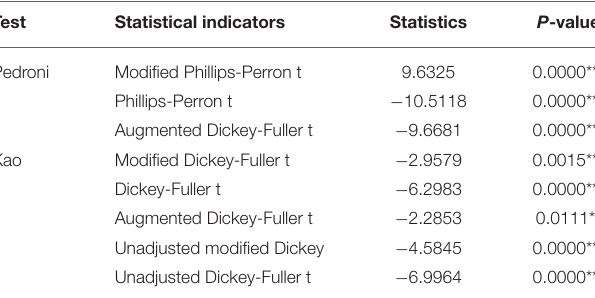
TABLE 3 | Co-integration